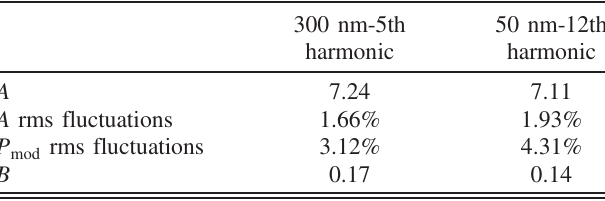
TABLE IV. The Table summarizes the mean normalized energy modulation A and the mean power in the cavity P passes with their rms fluctuations. In addition, the normalized dispersive strength B used for the analytical calculations in this section is shown.